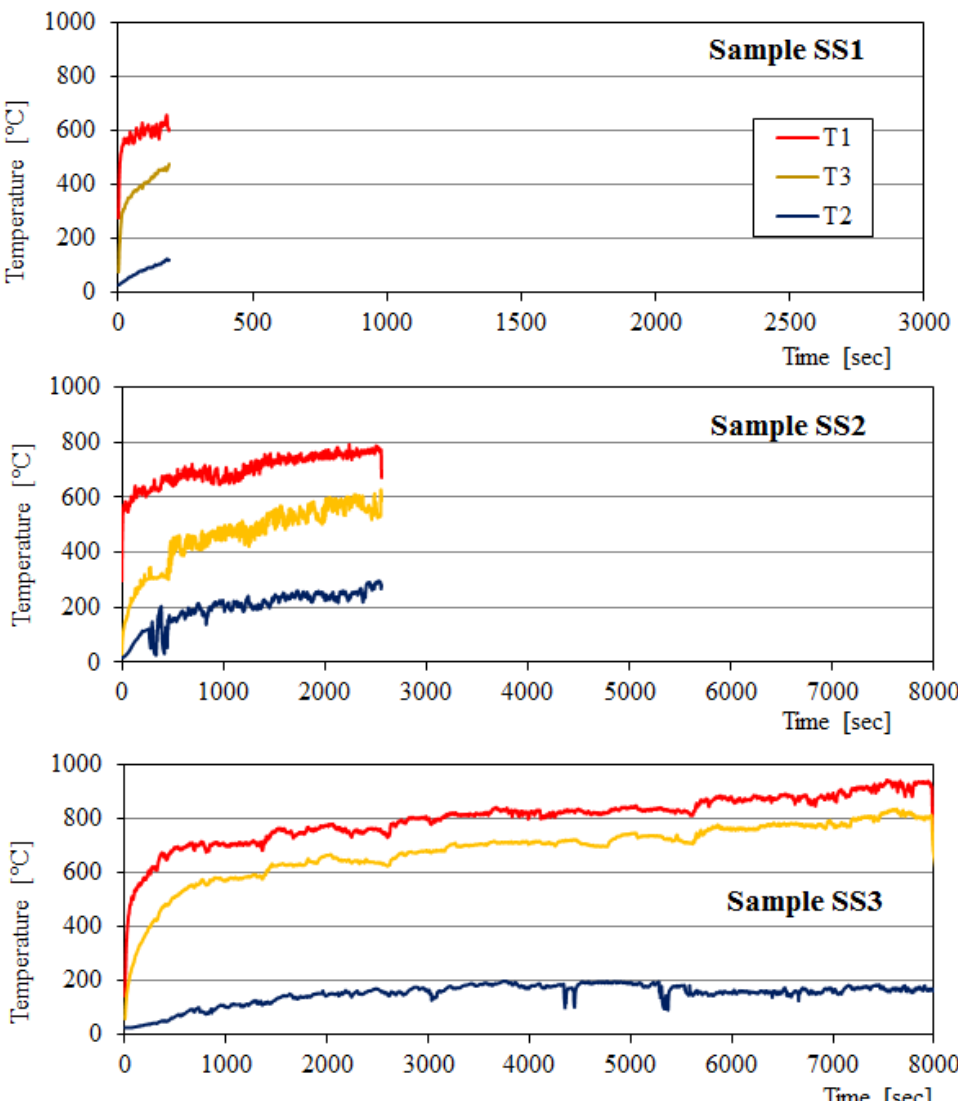
Figure 11. Temperature-time curves of fire resistance tests for the steel samples.